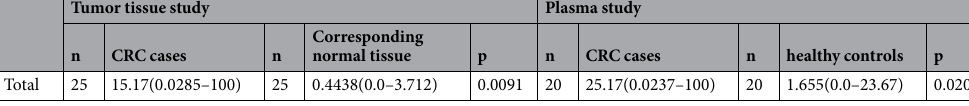
Table 1. Methylation status (%) of PCDH18 in tissues and plasma.